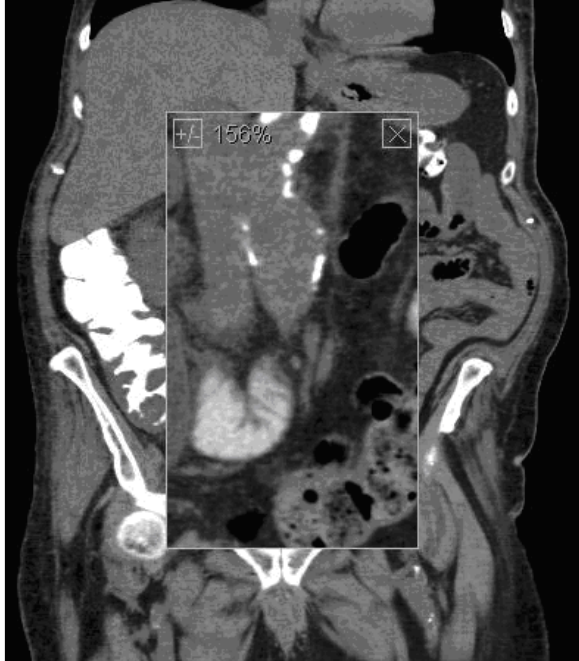
Figure 4 - A sagittal reconstruction shows the dilated gas- -filled left ureter.